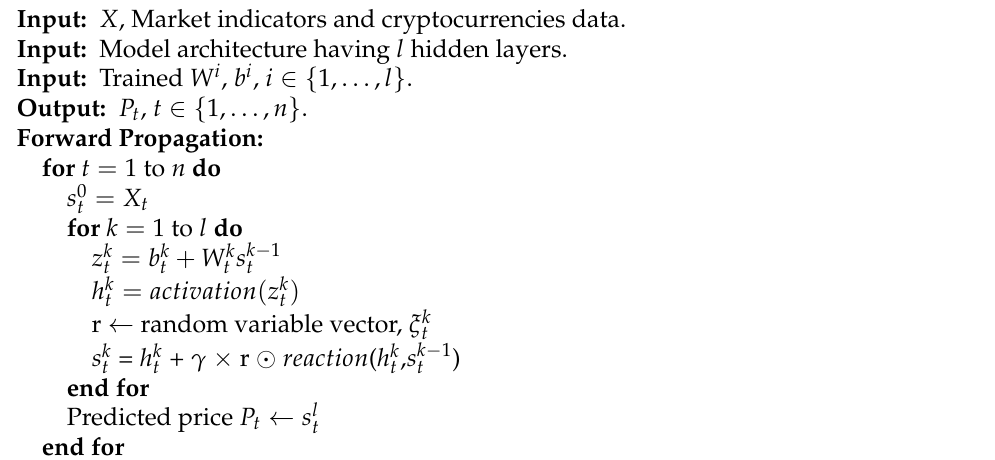
Algorithm 1 Forward propagation in a stochastic neural